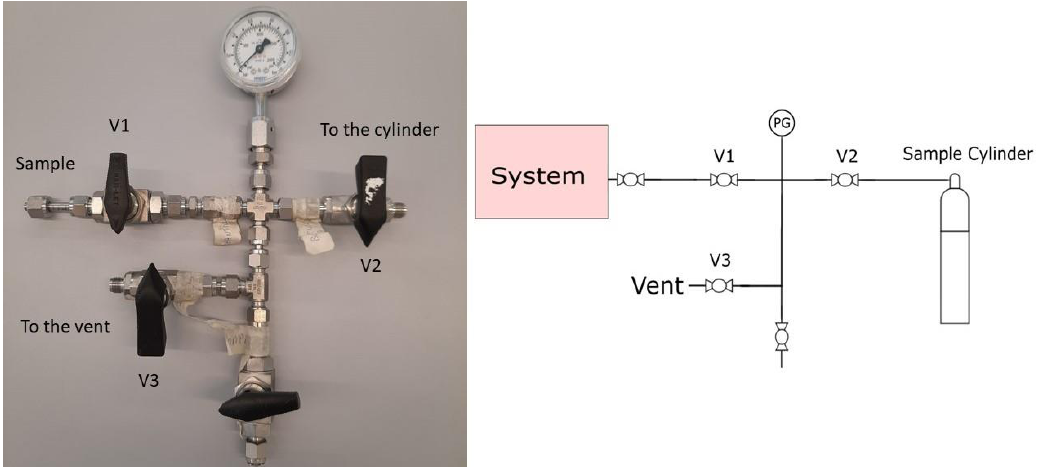
Figure 1. Schematic of sampling system used in this study.